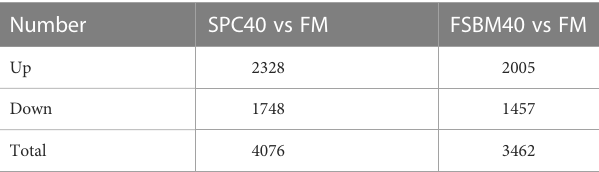
TABLE 5 Different soybean processing products substituted for fi shmeal in the distal intestine of the pearl gentian grouper for comparison of signi fi cantly different genes (n = 4).